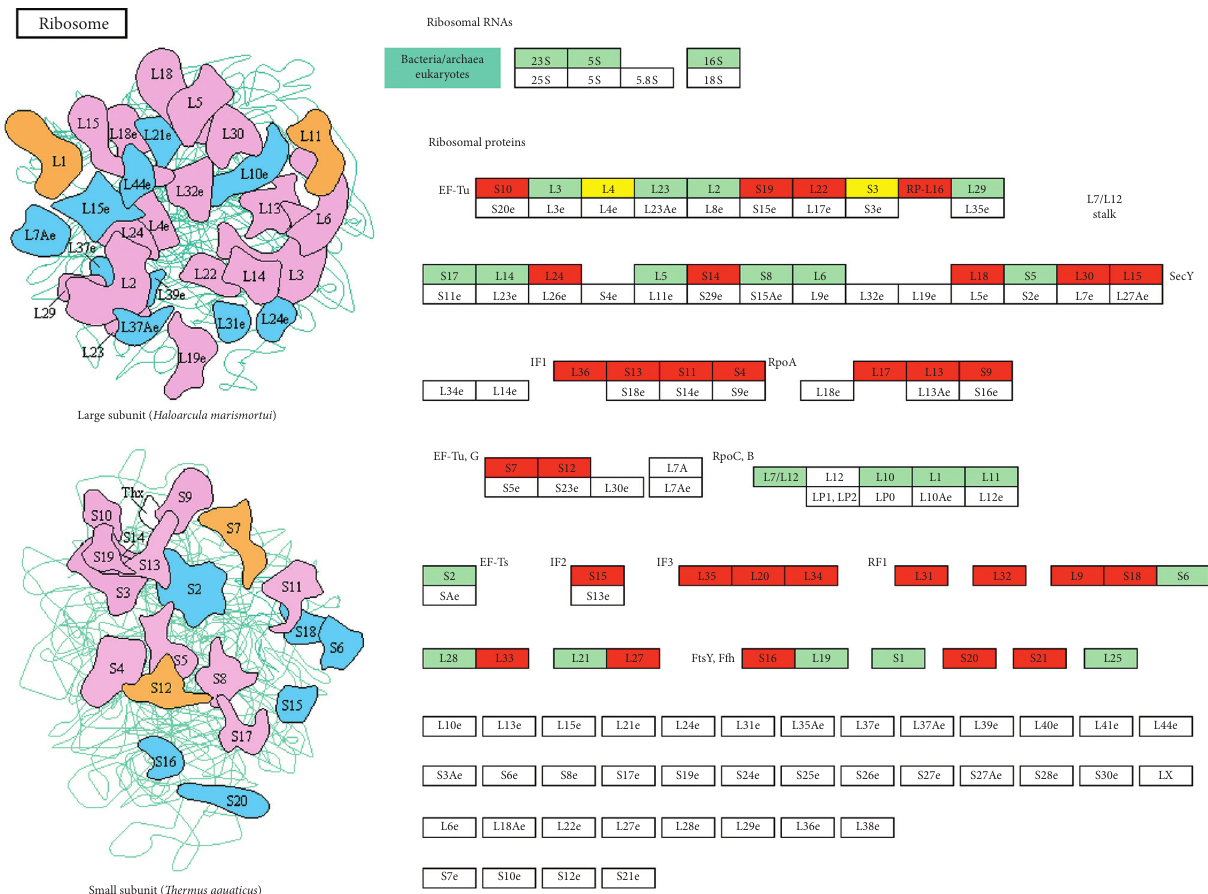
Figure 3: Schematic representation of the differentially expressed proteins involved in the ribosome pathway. The red boxes indicate the unregulated proteins, and the green boxes indicate the downregulated